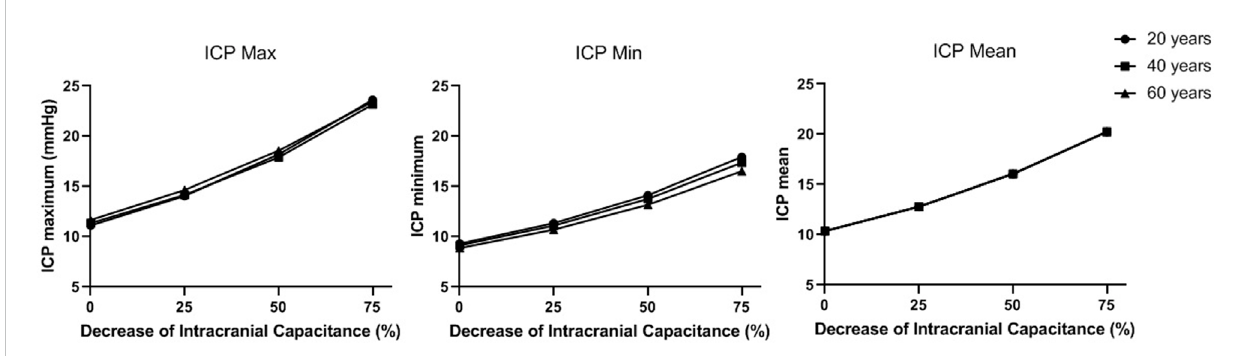
FIGURE 8 The maximum, minimum, and mean values of ICP in a cardiac cycle in different intracranial capacitance conditions.